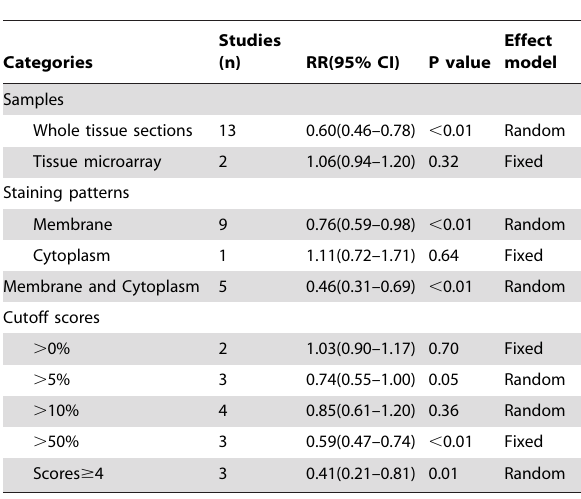
Table 2. Results of sensitivity analyses.